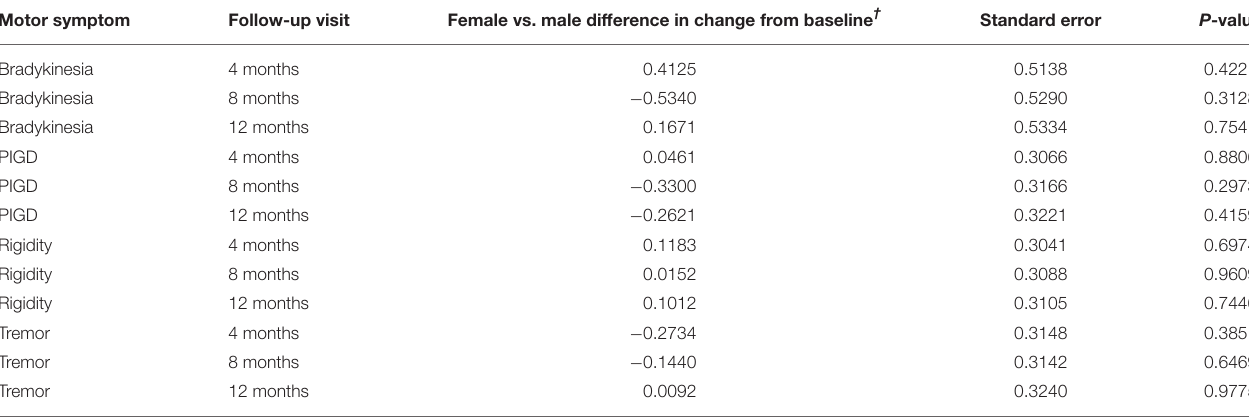
TABLE 4 | Changes of cardinal motor symptoms scores from baseline at each follow-up visit in female vs. male patients.